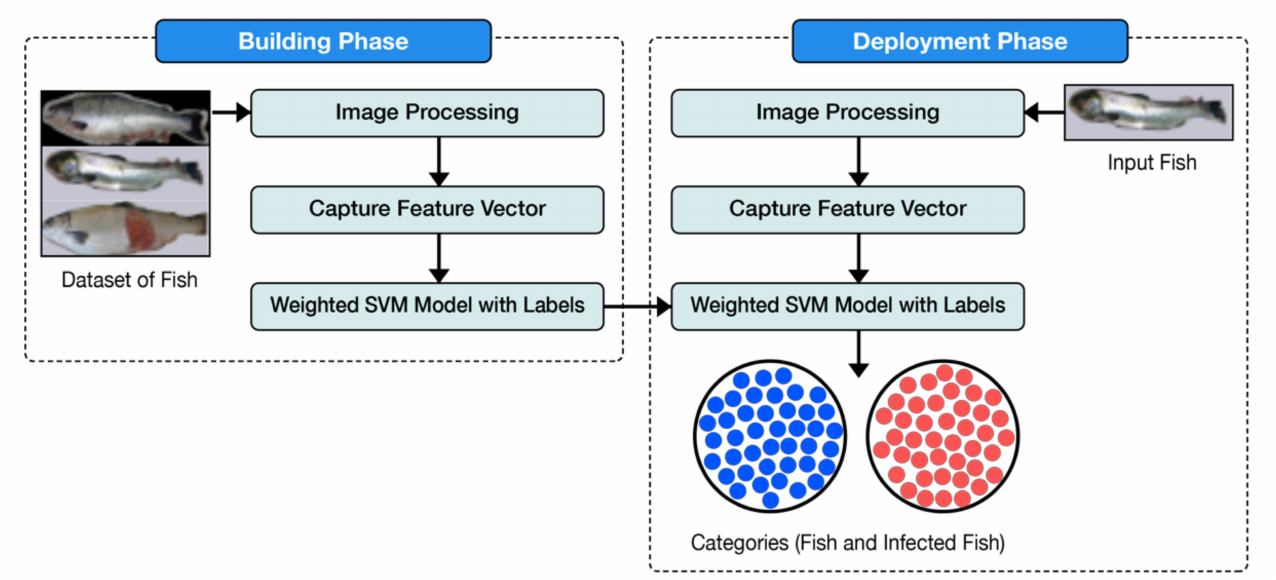
Figure 23. System architecture.